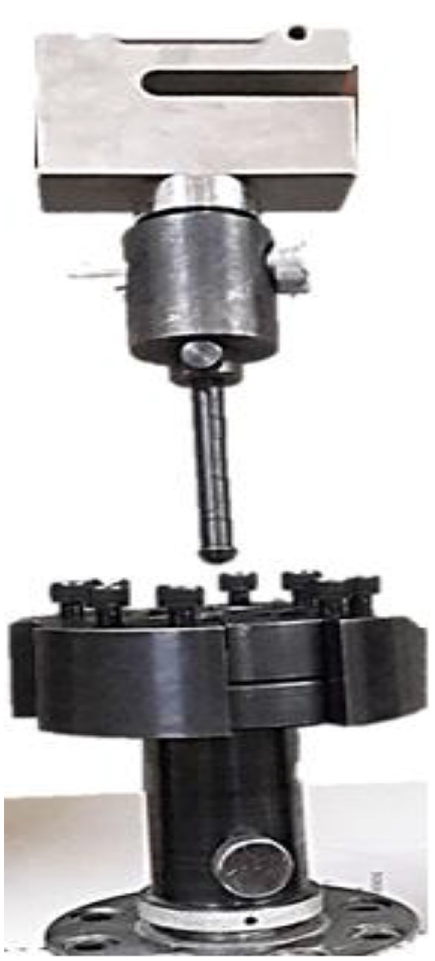
Fig. 1. LDH experimental